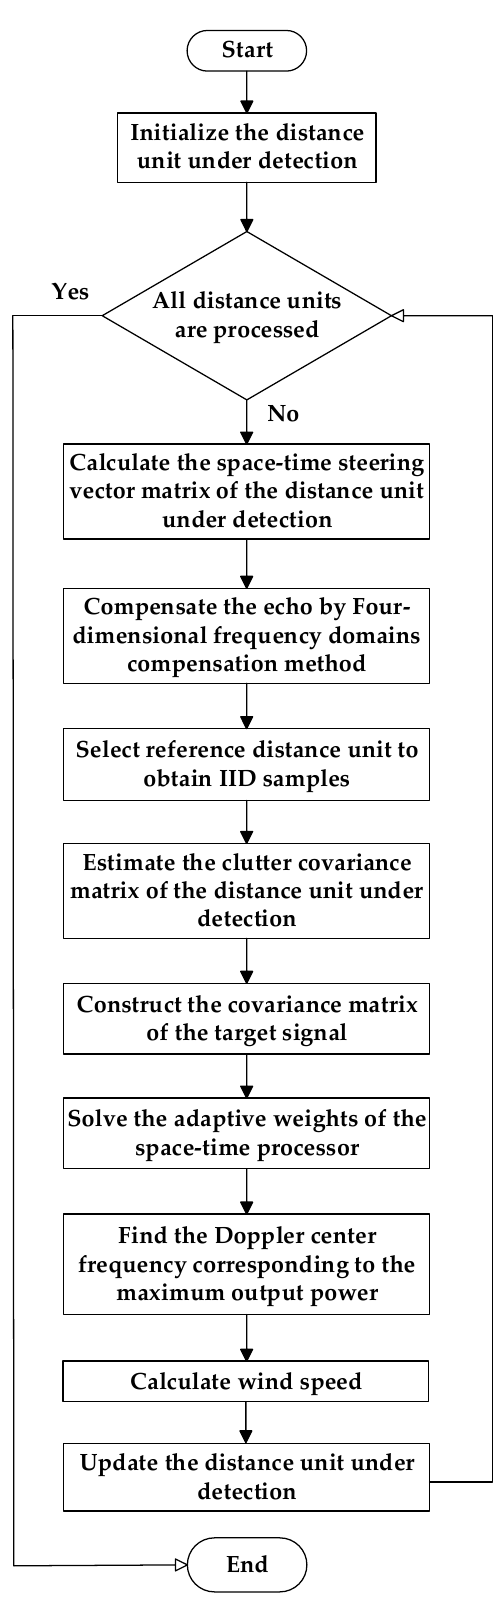
Figure 4. The basic flowchart of the low-altitude windshear estimation method under the fuselage frustum conformal array structure.